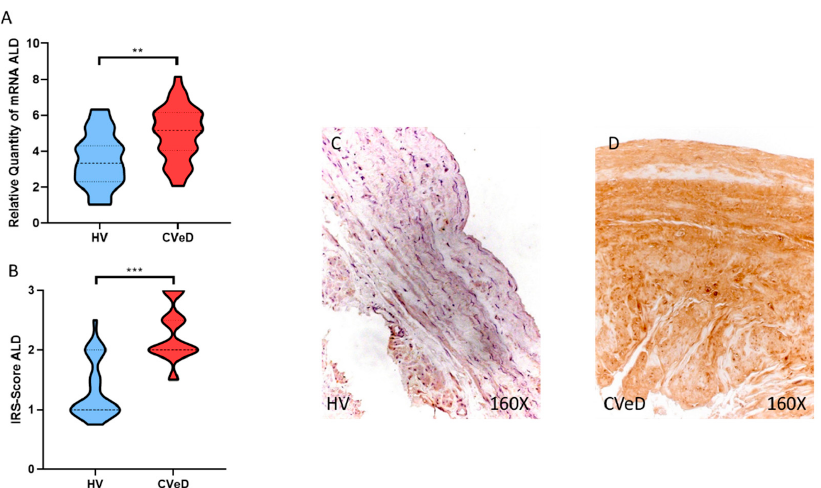
Figure 3. ( A ). ALD mRNA expression in the HV group (healthy controls) and CVeD patients (chronic venous disorder). ( B ). IRS-Scores for ALD in the venous wall of the HV group and the CVeD group. ( C – D ). Images showing the immunostaining for ALD in the C group in the three tunicae of the venous wall. p < 0.01 (**) and p < 0.001 (***).